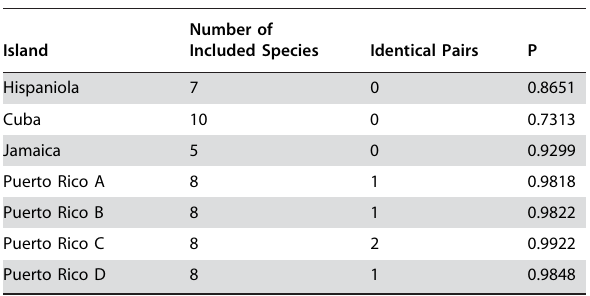
P-values represent the proportion of randomly assembled communities with the same or fewer identical pairs of species. The four results from Puerto Rico reflect the inclusion of four different dewlap forms for A. cristatellus .